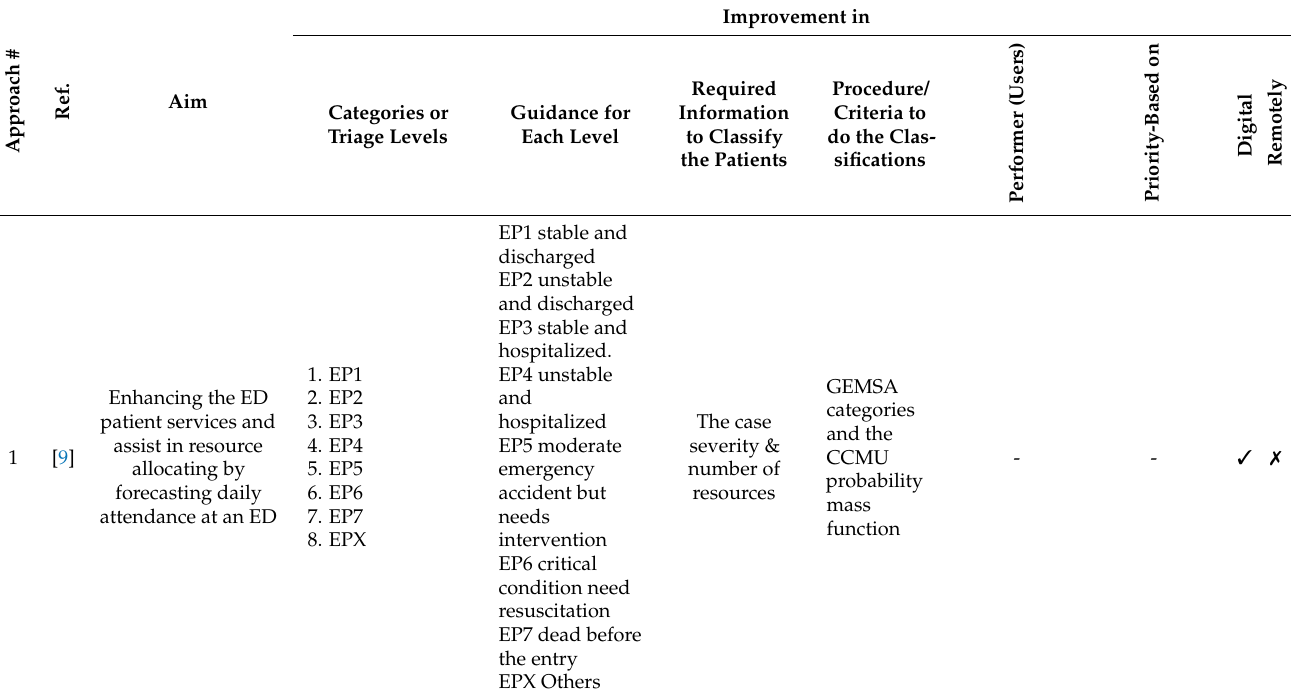
Table 2. Comparison of general proposed ED triage systems.